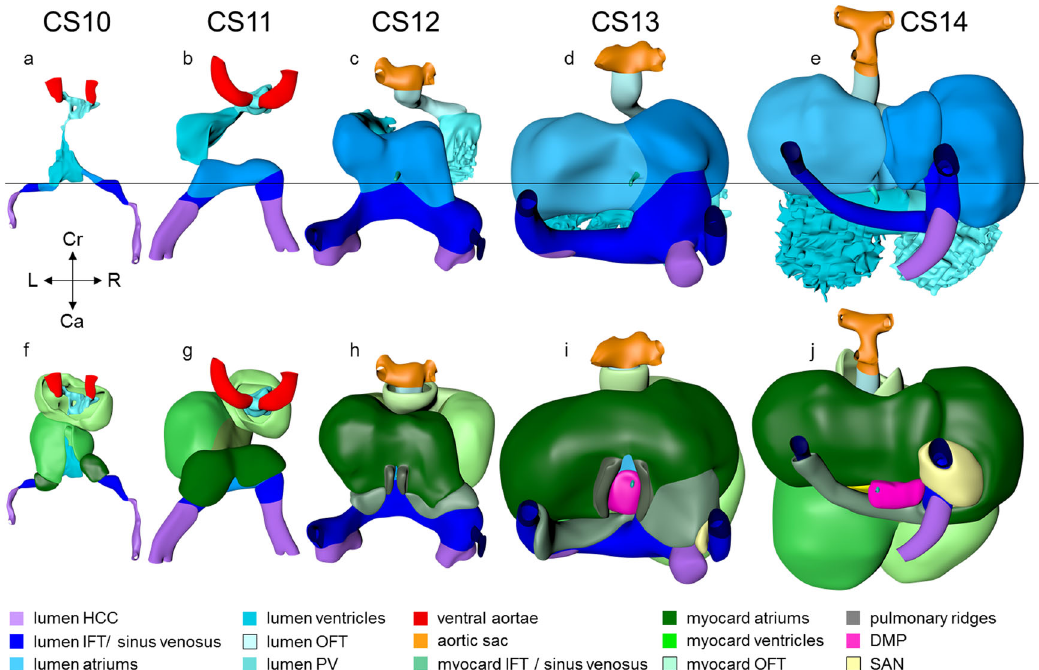
Fig. 1 Pictorial timeline of the development of the in fl ow tract. Dorsal views of embryonic hearts are shown between CS10 and CS14, with panels a – e emphasizing endocardial continuity and panels f – j the myocardial coat. The panels are aligned relative to the position of the pulmonary vein (black horizontal line). Note that the distance between the arterial and venous poles of the heart loop does not change during cardiac looping (CS10-CS12; 52,55 ). The appearance of a myocardial wall indicates the formation of that compartment in the in fl ow tract. Myocardium appears in the wall of the atrium at CS10 and in the wall of the systemic venous sinus at CS12. The pulmonary vein, along with its fl anking atrial ridges, also begins to form at CS12. The sinus node becomes recognizable as a separate structure at CS13. The left and right atriums are already distinguishable at CS10, but the sinuatrial junction does not become a right-sided structure until CS13. The atrial septum appears at CS14. It is identi fi able as the “ empty ” space between left and right atriums in panel e . The hepatocardiac veins are the only source of venous blood for the heart until CS12, when the initially small common cardinal veins appear. All images are also available as preset views in the corresponding